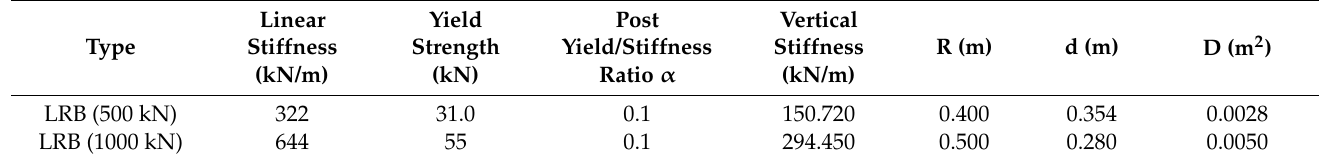
Table 5. Properties of the lead rubber bearings.